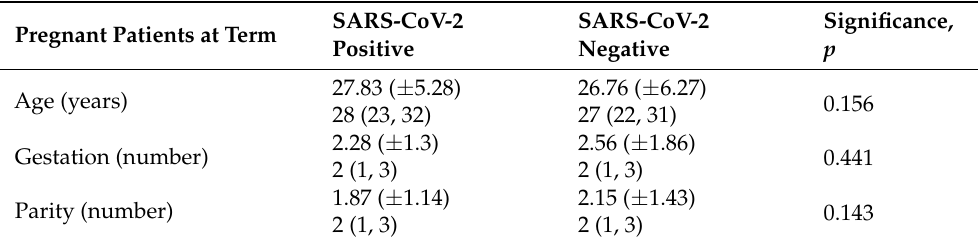
Table 1. Patient characteristics: mean values (and standard deviation) on the upper line and median values (quartile 1, quartile 2) on the lower line of each value